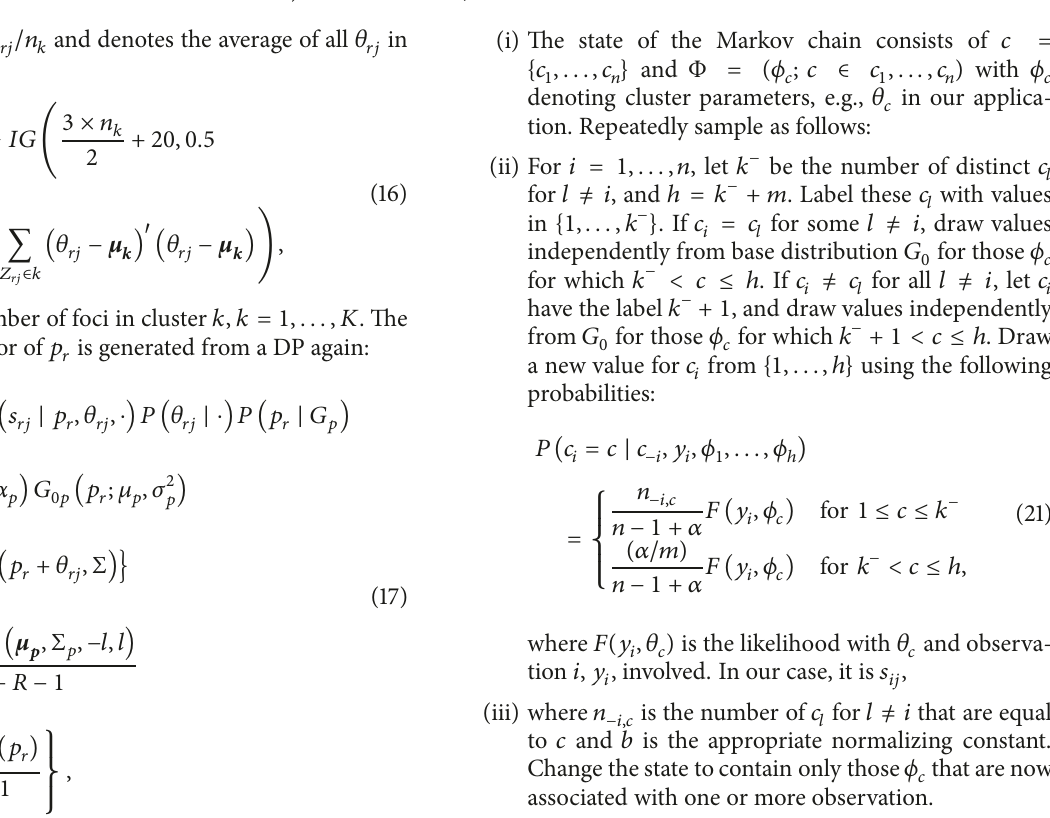
Algorithm 8 for updating clustering assignments, denoted as